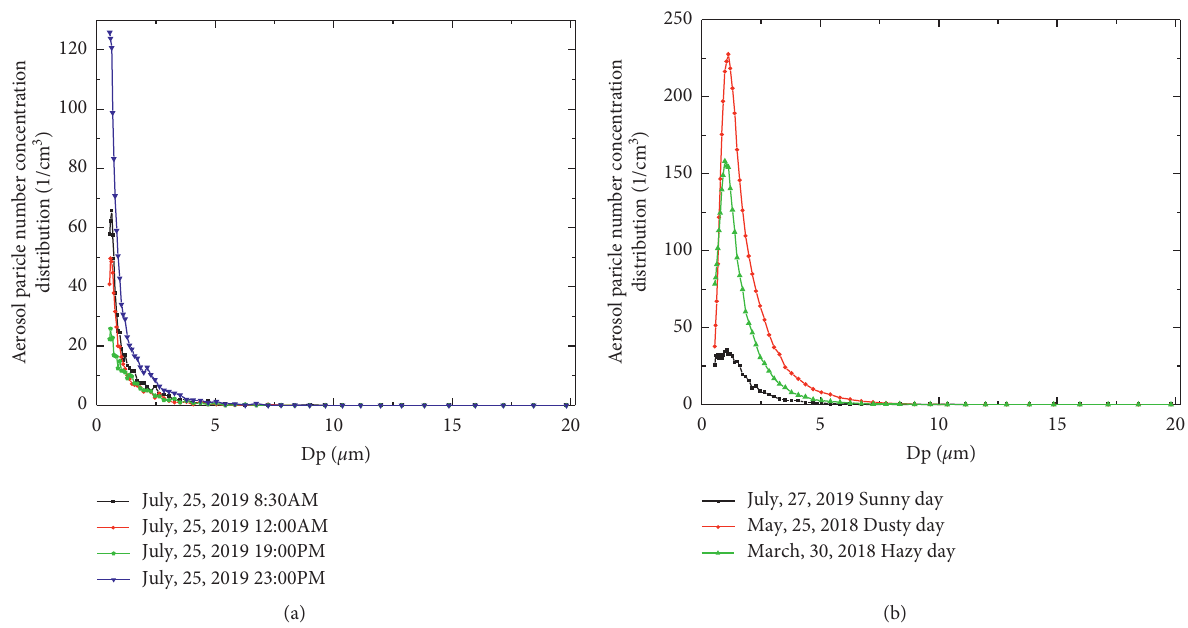
Figure 2: (a) The aerosol PSD on July 25, 2019 and (b) at the same moment under different weather conditions.